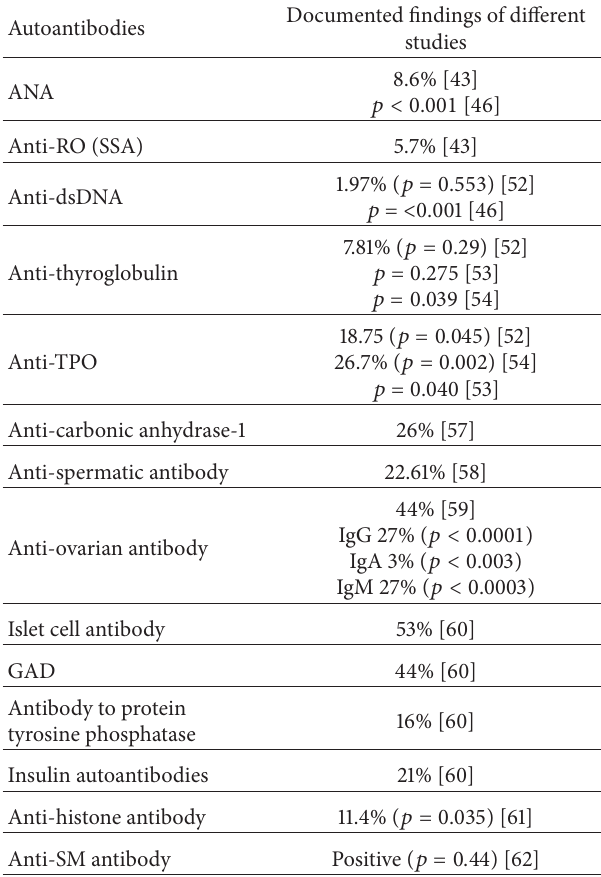
Table 3: Reported autoantibodies in